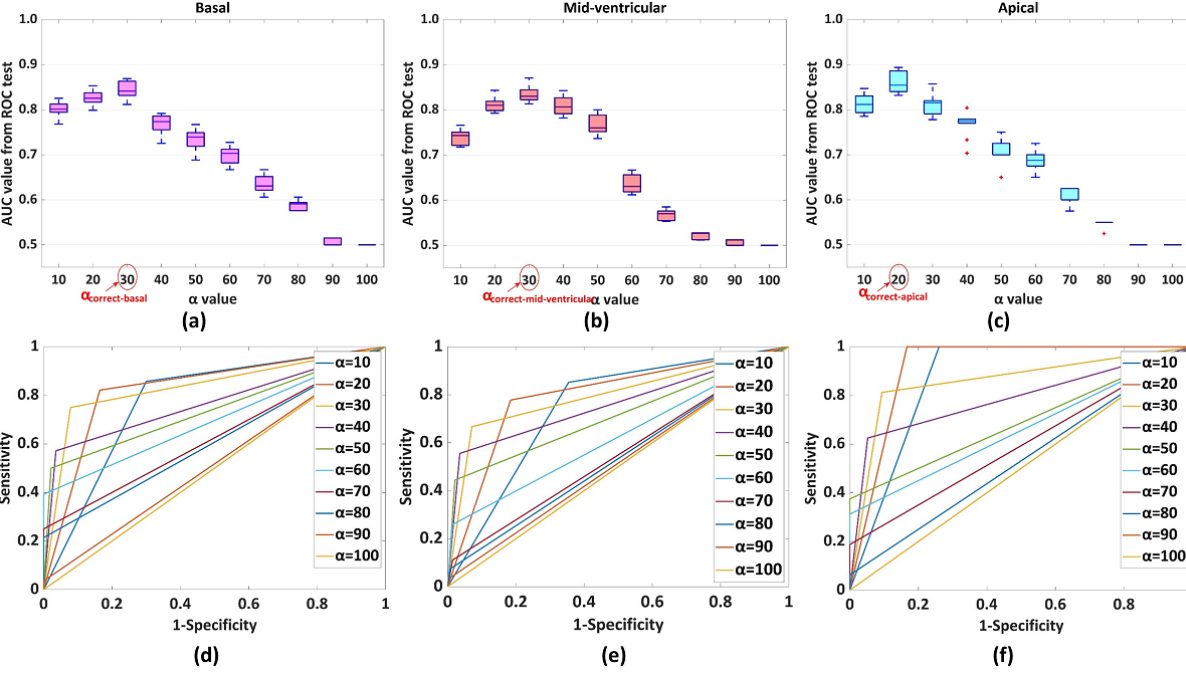
Figure 4. Overall results of 10 k-fold cross-validation tests. Overall AUC values using each α are shown in (a) basal, (b) mid-ventricular, and (c) apical slices. Red circles denote α correct corresponding to the maximum AUC for the respective slice. Examples of ROC test results for (d) basal, (e) mid-ventricular, and (f) apical slices, respectively. AUC: area under the curve; ROC: receiver operating